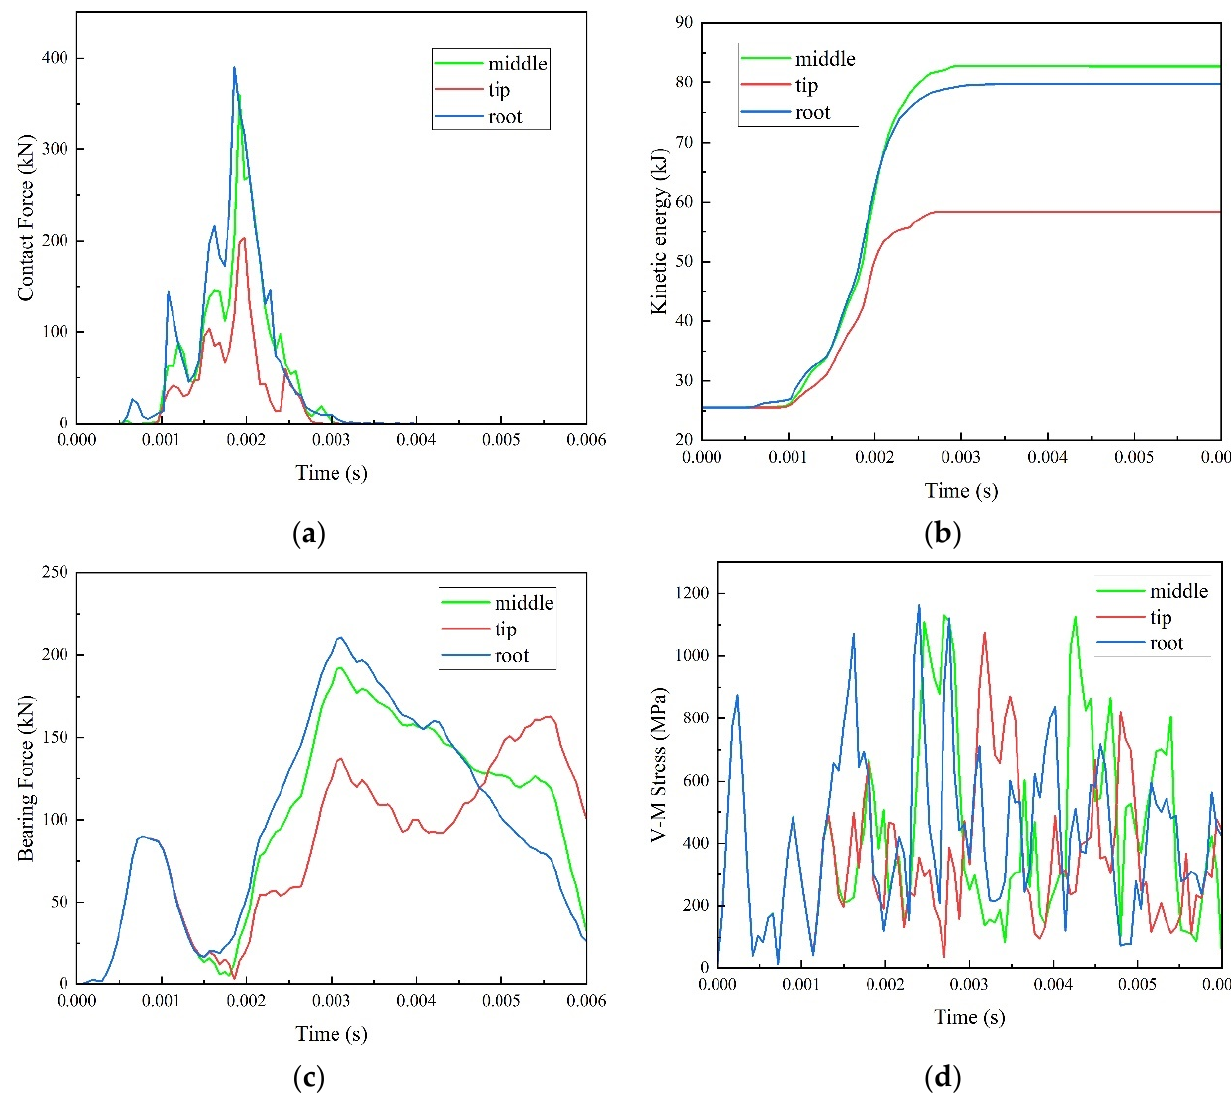
Figure 8. Variations of ( a ) contact force; ( b ) bird kinetic energy; ( c ) bearing force; and ( d ) von Mises stress with respect to time for different impact